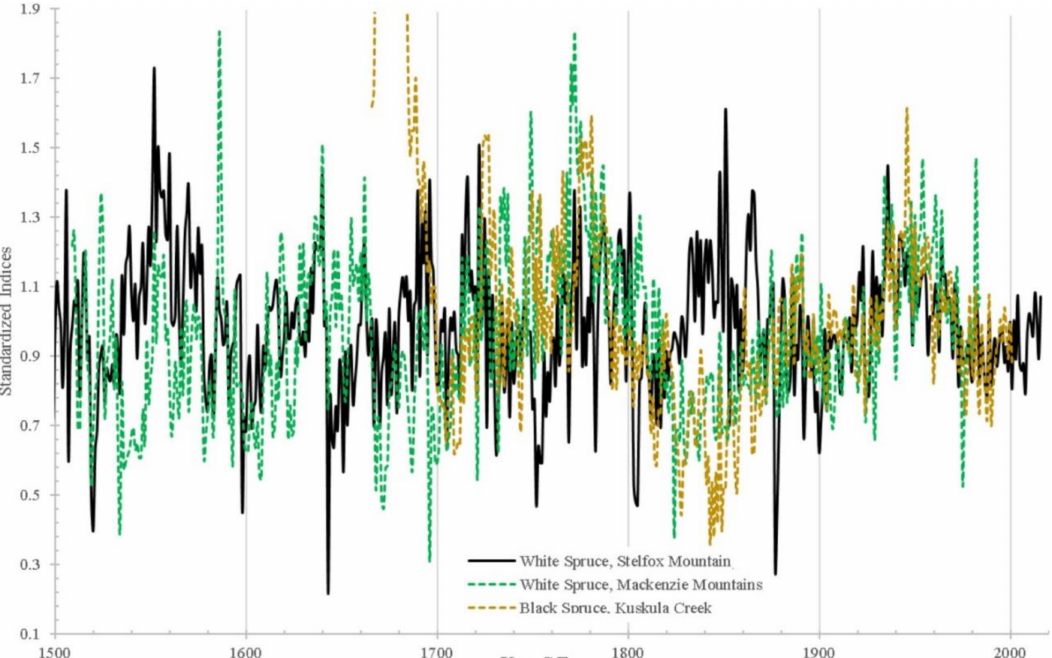
Figure 7. A comparison of the Stelfox chronology (black) and the two other closest chronologies available through the International Tree Ring Data Bank over their common interval. The three chronologies compare well both visually and statistically except for a short period in the early to